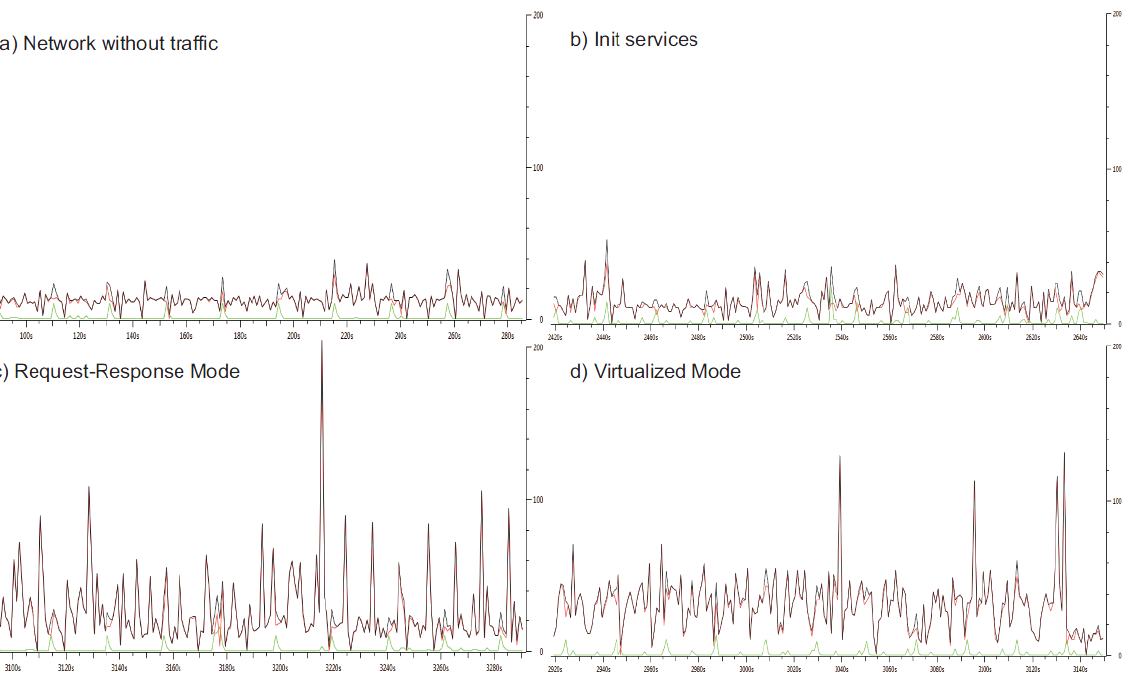
Figure 6. Network traffic evolution in four states: ( a ) without traffic; ( b ) with the initialization (init) of services; ( c ) in request-response mode and ( d ) virtualized